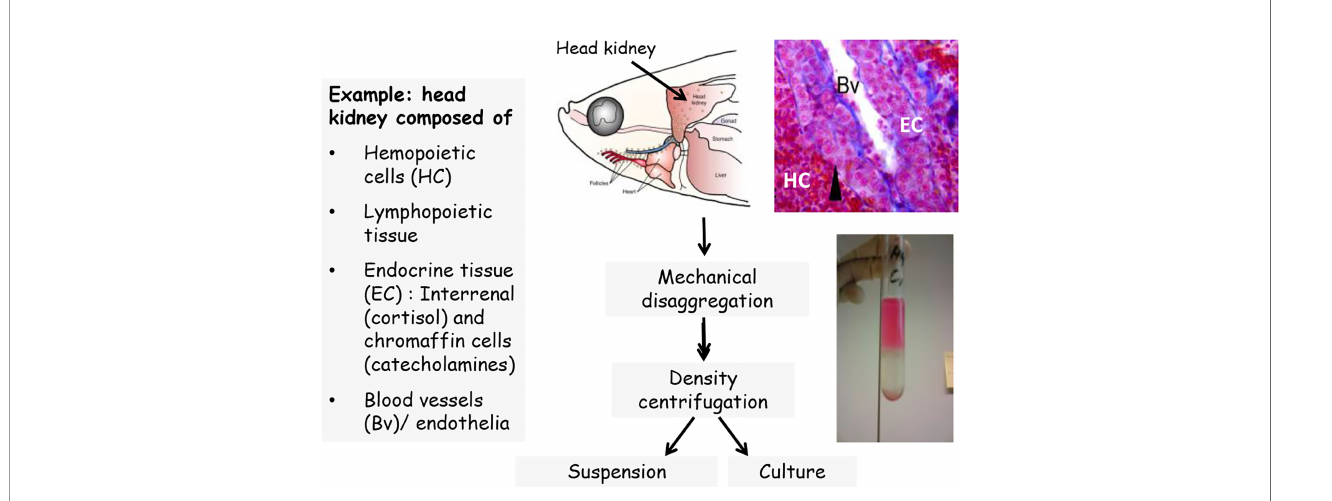
FIGURE 1 | Scheme of leukocyte isolation, exempli fi ed for head